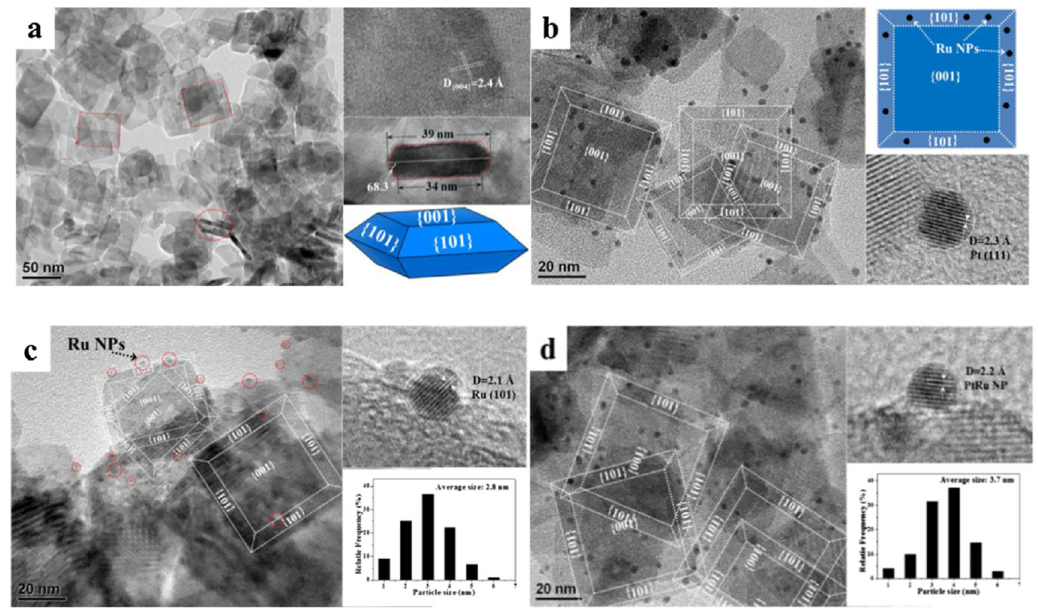
Figure 5. Microscopic images of anatase nanoparticles ( a ), of anatase nanoparticles loaded with Pt ( b ), with Ru ( c ), and with PtRu, and ( d ) using photodeposition. The insets in (a) and (b) represent the shape of the nanoparticles. The insets in (c) and (d) represent the size distribution. Reproduced from Reference [43] with permission; copyright (2018) Elsevier.